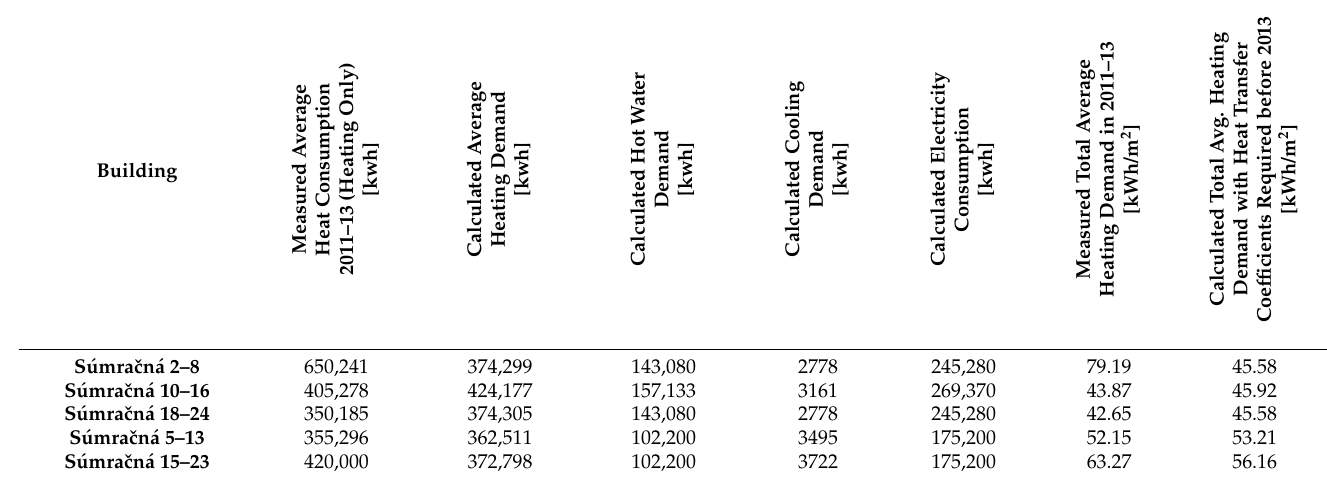
Table 3. Comparison of the measured annual average heating energy demands during years 2011–2013 and the calculated energy demands of five residential buildings in the Ostredky housing estate, Bratislava. The parameters of the building envelope used in the calculation correspond to the standards of the heat transfer coefficient before 2013 with no ventilation heat recovery. Two columns on the right show the difference between measurement and calculation per m 2 of floor area; notable differences are in case of S ú mraˇcn á 2–8 and S ú mraˇcn á 15–23, where basic refurbishment has not yet been completed.